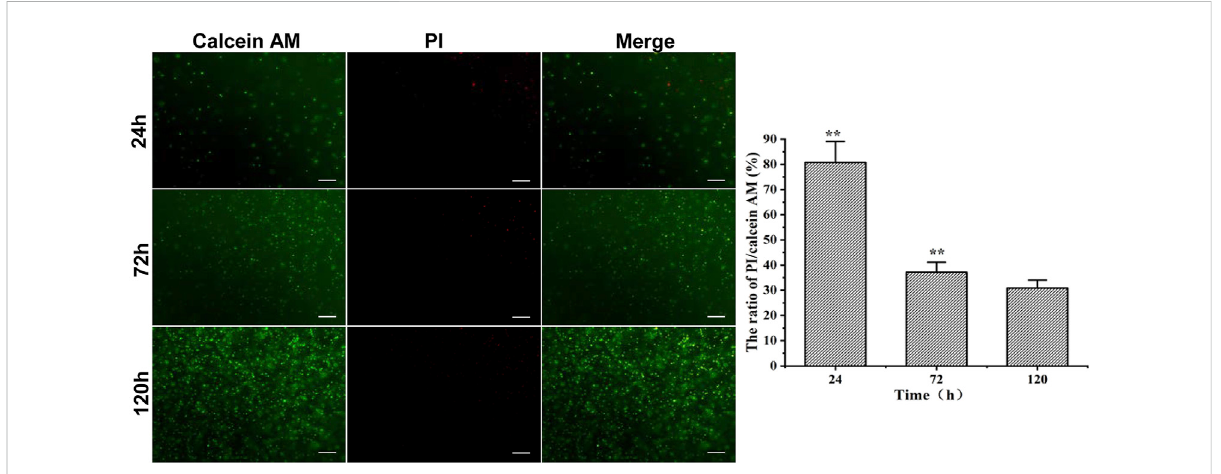
FIGURE 4 RMSCPI/CalineinAMassayin3.5%HA-F127at24,72,120 h.3.5%HA-F127for120 hshowedthattheratioofthered fl uorescence(dead)/green fl uorescence (live) was signi fi cantly lower than 24 and 72 h (**, p < 0.01), indicating that the RMSCs obtained more better medium to survive and proliferate well in the hydrogel.